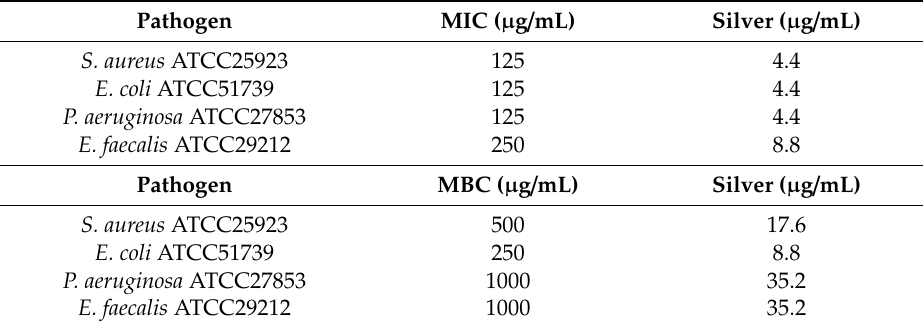
Figure 1. Inhibition curves for the three test materials added to bacterial suspensions of: ( a ) the S. epidermidis strain RP62A and ( b ) the E. coli ATCC ® 51739. Data reported in the plot correspond to the mean OD values of the triplicate wells of the independent experiments performed ± S.D. Table 3. MIC and MBC values for